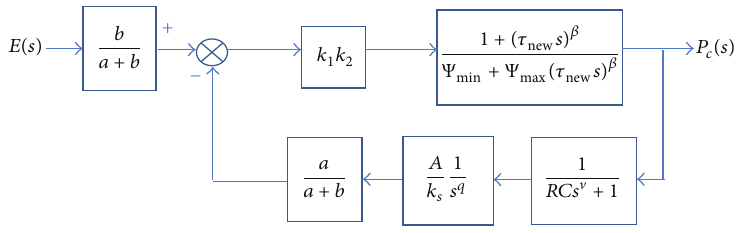
Figure 5: A simplified block diagram for fractional order PD controller.